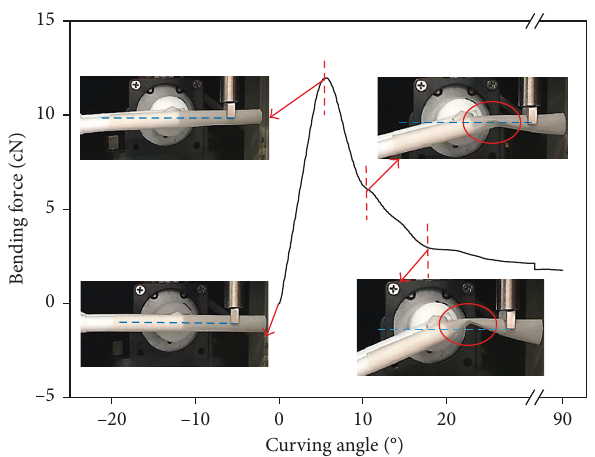
Figure 4: Typical bending curve of tubular fabric (blue dotted line refers to the horizontal position).